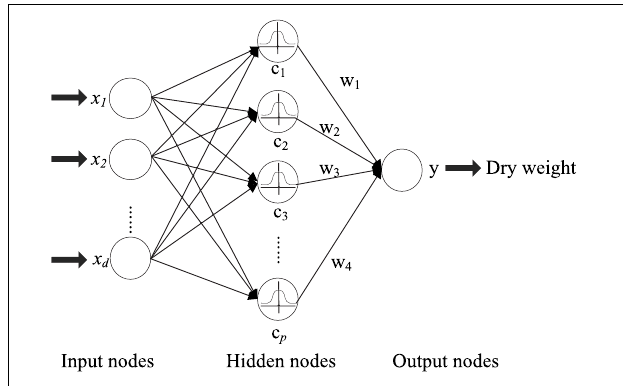
FIGURE 1 | Topological structure of the radial basis function (RBF) network.